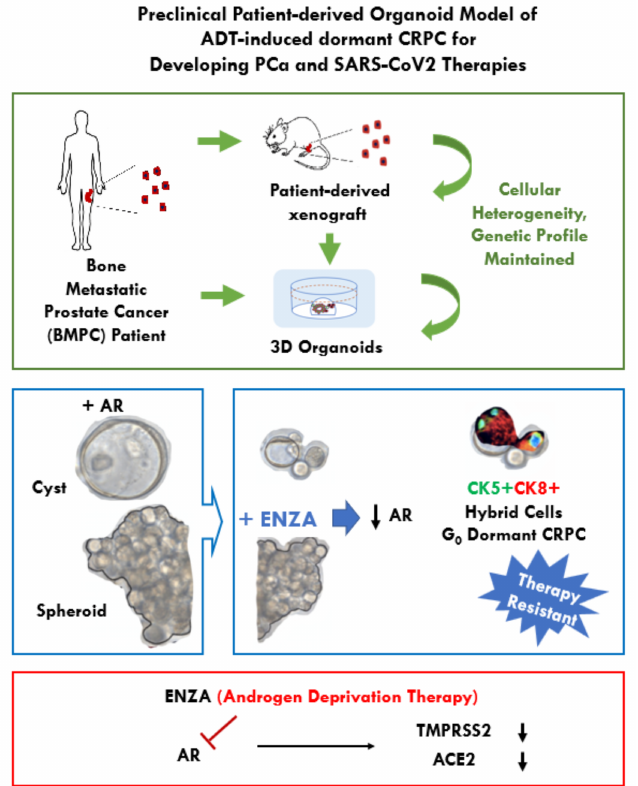
Figure 6. Novel dormancy mechanism of castration resistance in a bone metastatic prostate cancer organoid model. Overview of the PCSD1 patient-xenograft derived organoid (PDO) model for bone metastatic prostate cancer and its response to androgen pathway directed therapy. This model can be used for further understanding of tumor resistance, progression and dormancy under therapies that suppress the androgen